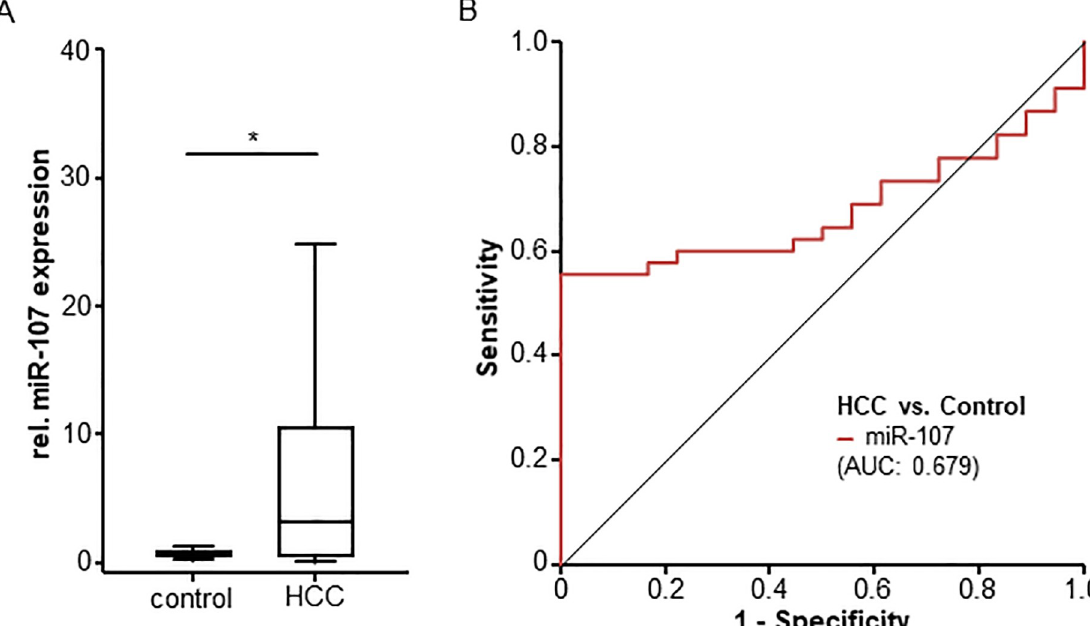
Fig 2. MiRNA-107 levels are upregulated in HCC patients. (A) Circulating miR-107 levels are significantly higher in HCC patients compared to healthy controls. (B) Circulating miR-107 levels show an AUC value of 0.679 regarding the discrimination between HCC and healthy